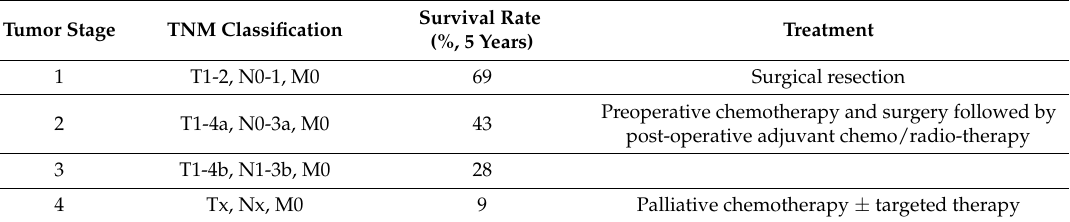
Table 1. Tumor stage and associated survival